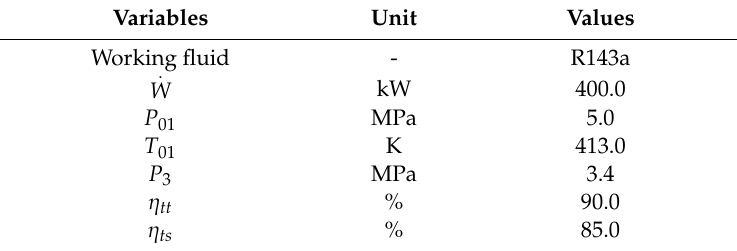
Table 1. Design values of a radial outflow